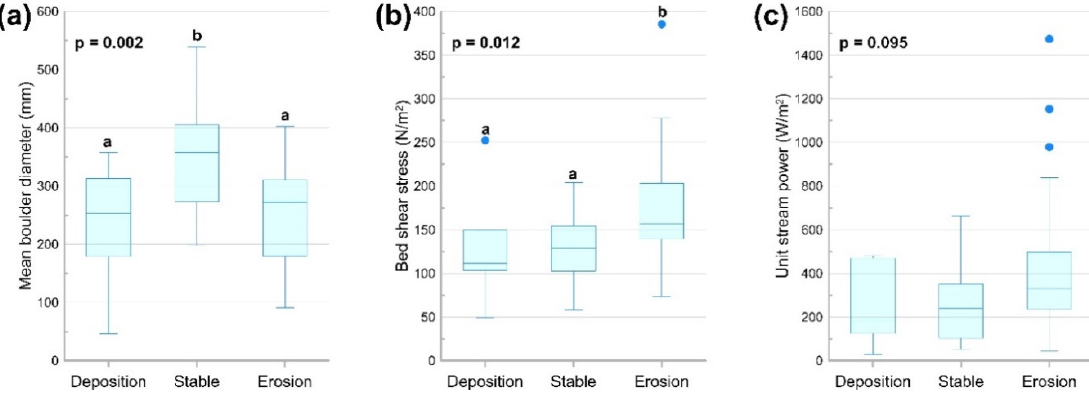
Figure 10. Boxplots of mean boulder diameter, bed shear stress and unit stream power calculated for the 2014 event ( Q optimum scenario) in erosional, stable and depositional cross sections. The letters above the boxes show significantly different groups by Z -value test with Bonferonni corrections.